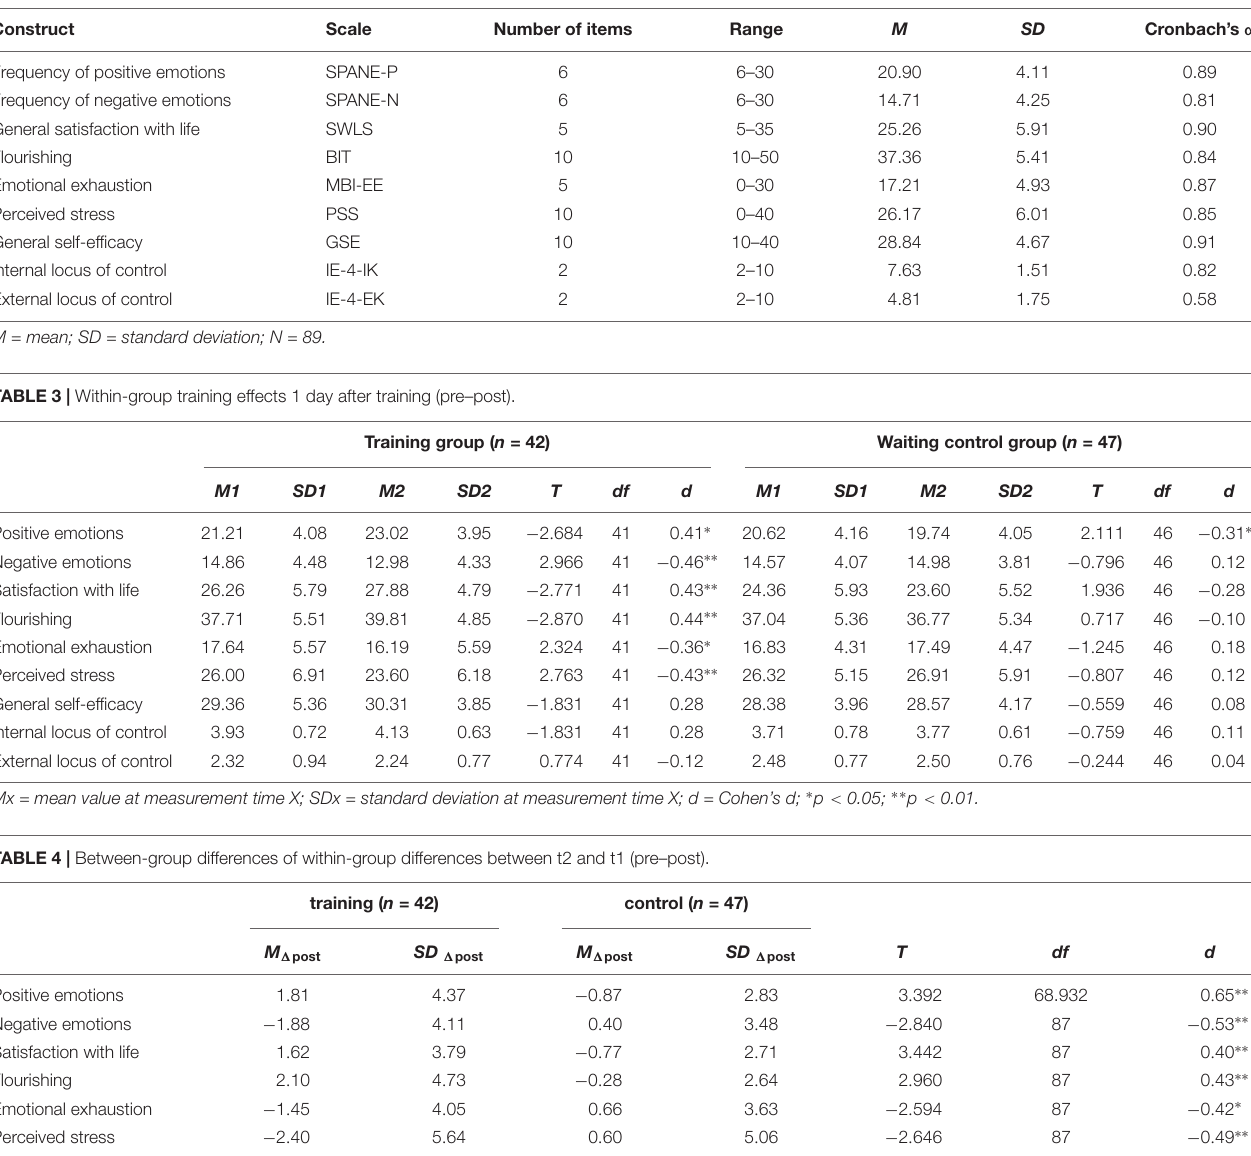
TABLE 2 | Scale characteristics (pre).